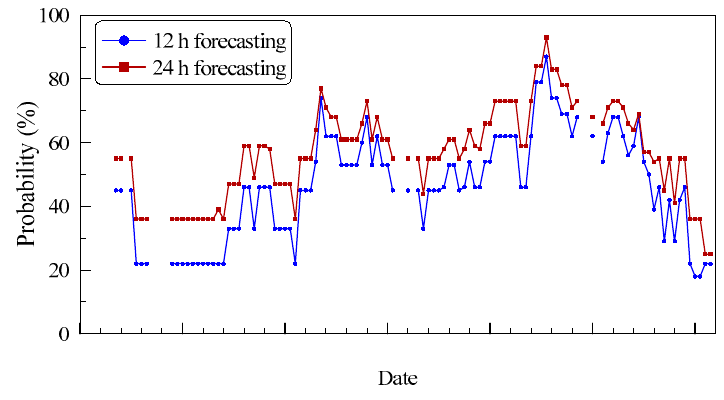
Figure 4. Probability of CFW occurrence during operational testing.